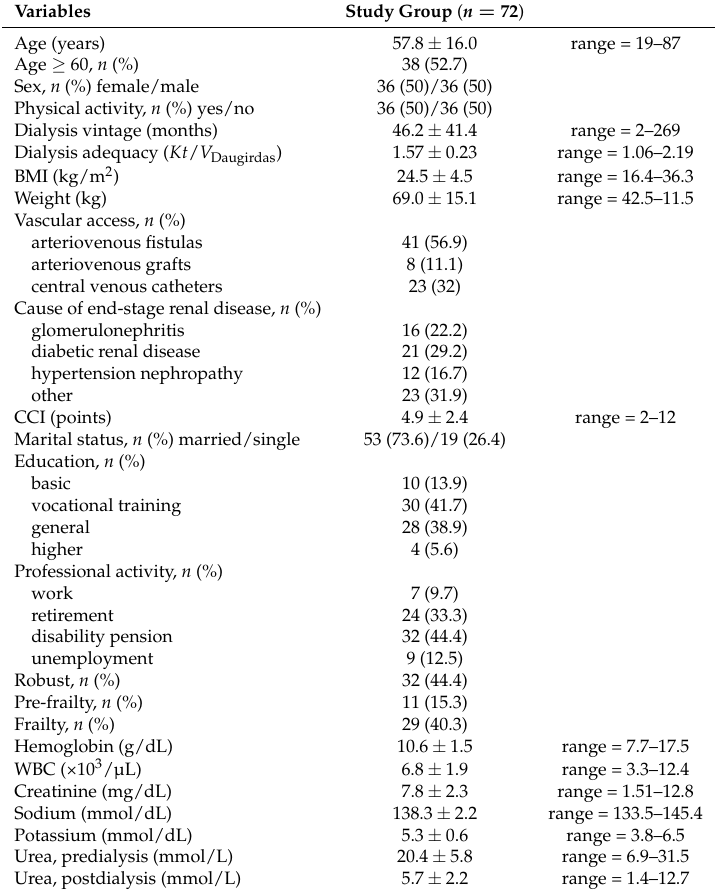
Table 1. Basic sociodemographic and clinical characteristics of patients participating in the